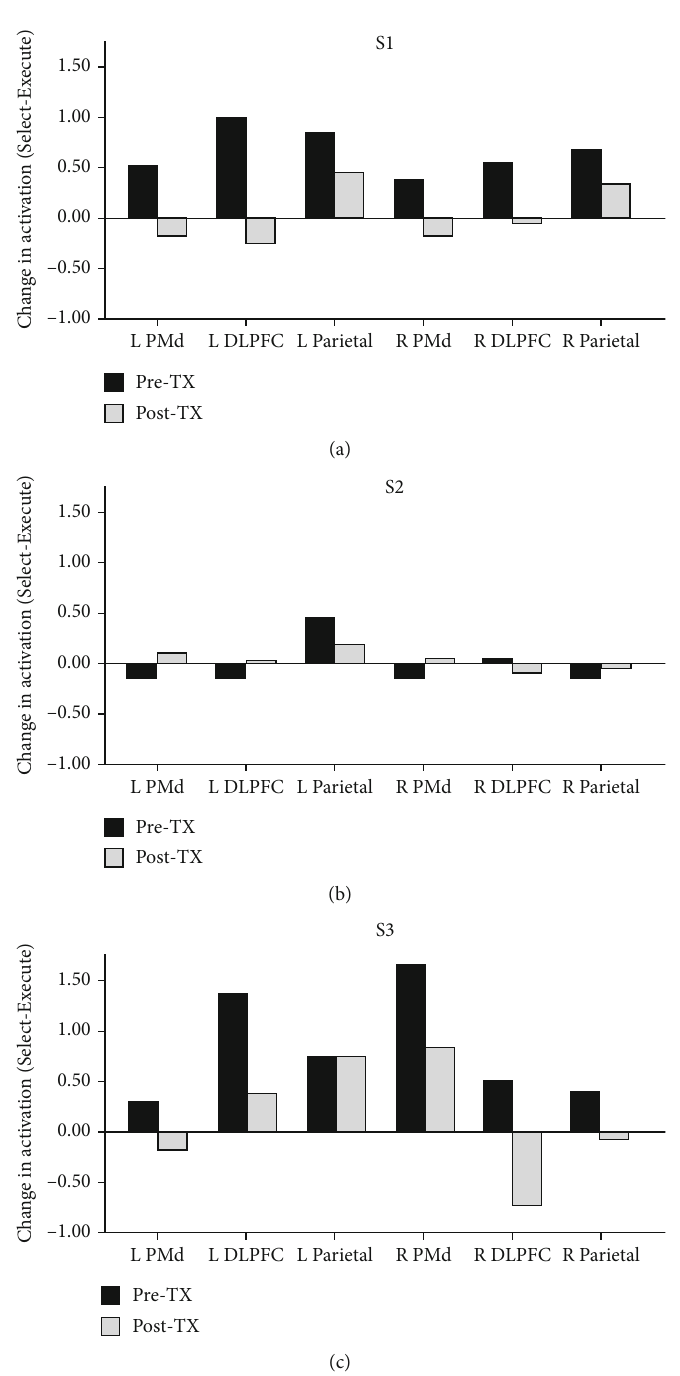
Figure 5: Brain activation in regions of interest during Select performance with the more impaired hand before (Pre-TX) and after (Post-TX) training for S1 (a), S2 (b), and S3 (c). Each bar represents the change in activation during the Select condition relative to the Execute condition on each day. Left (L) is the ipsilesional side. Right (R) is the contralesional side. PMd = dorsalpremotorcortex ; DLFPC = dorsolateral prefrontalcortex